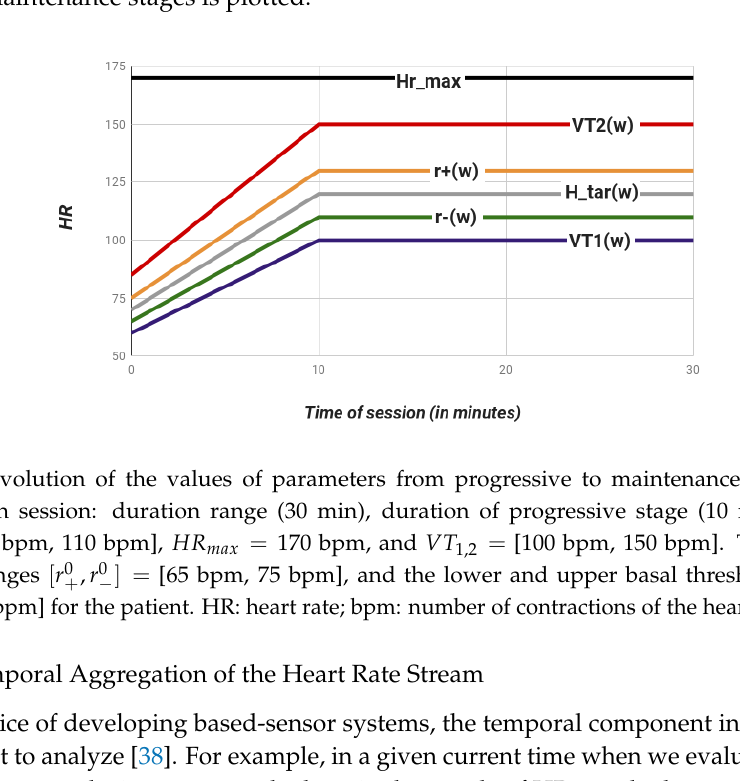
= [100 bpm, 150 bpm]. This includes 1,2 = 1,2